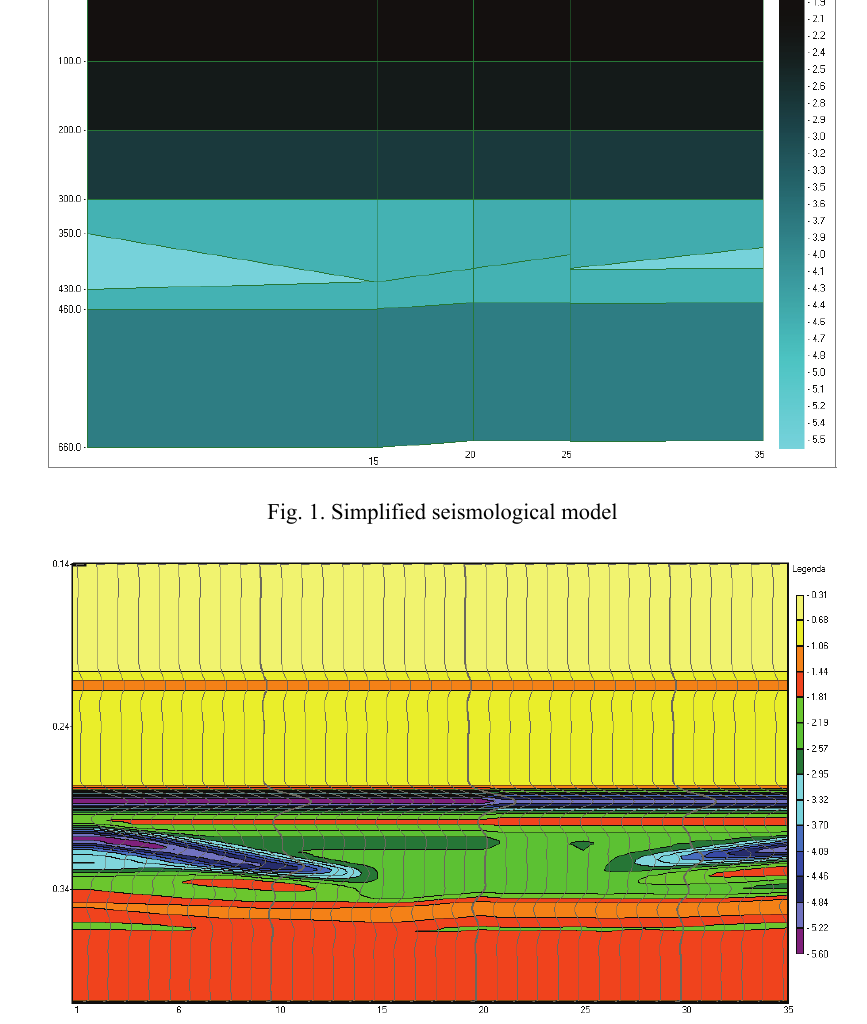
Fig. 2. Synthetic pseudoimpedance acoustic section; signal